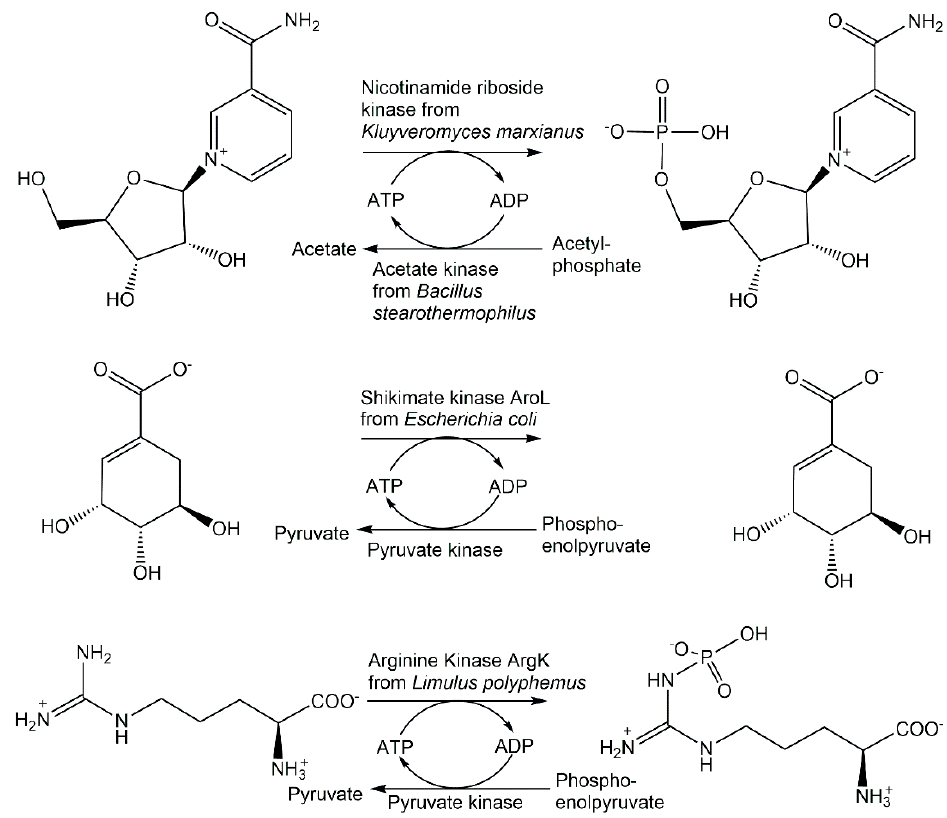
Figure 14. Synthetic applications of phosphotransferases in phosphorylation